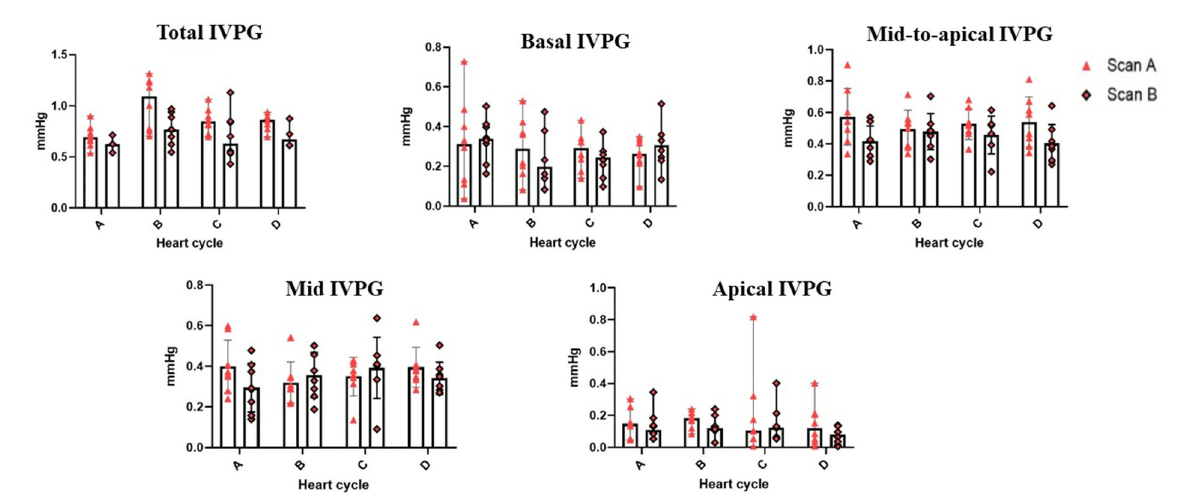
FIGURE3 Variability of CMME-derived intraventricular pressure gradients (IVPG). Variability was calculated within goats between heart cycles and between time by two observers (scans A and B); n = 8.